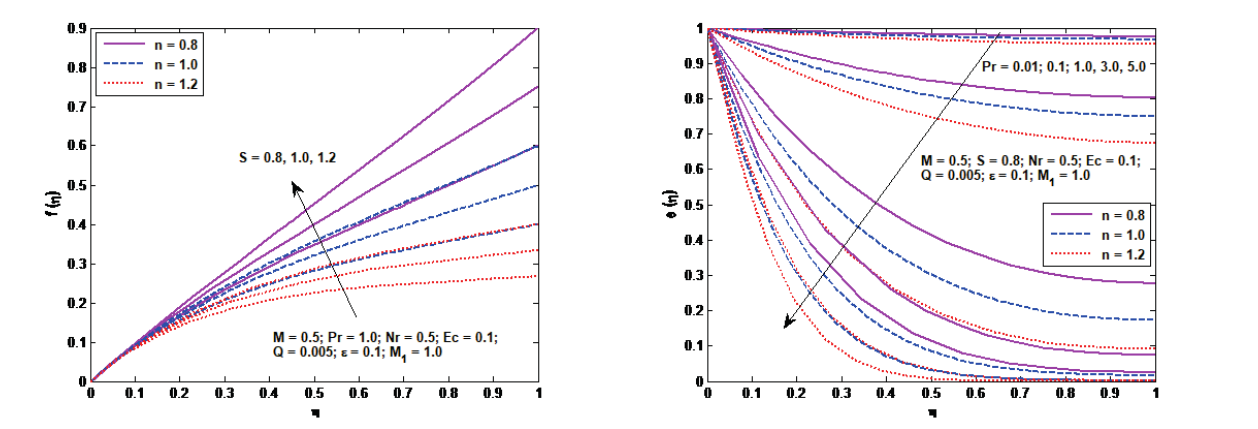
Fig. 7: Transverse velocity profiles for different values of S